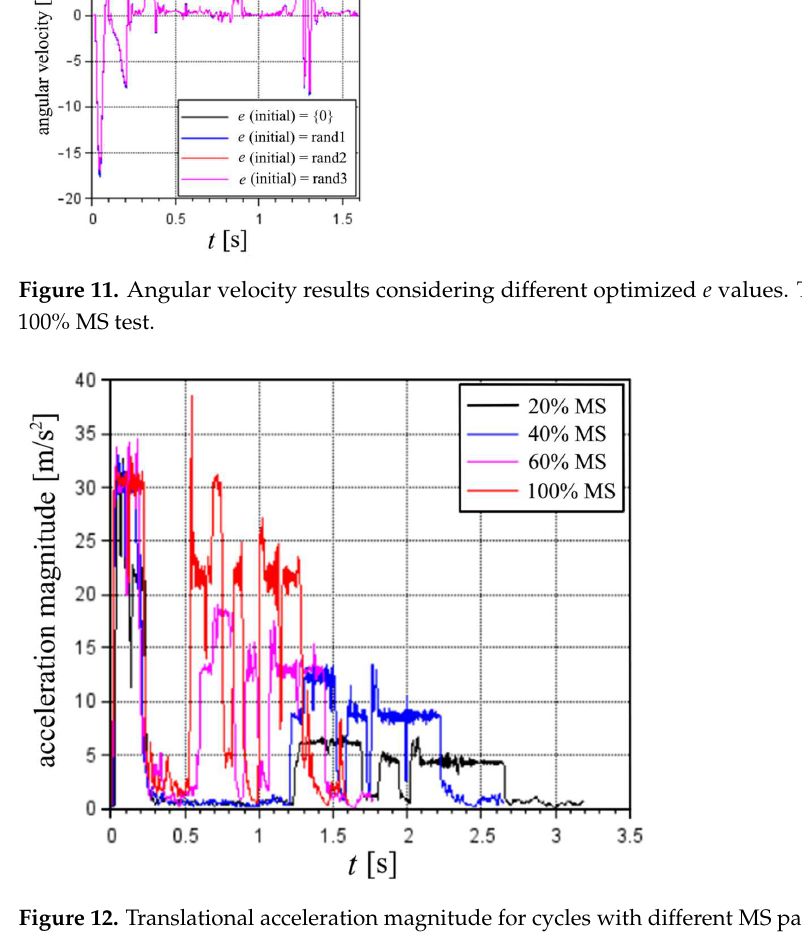
Figure 12. Translational acceleration magnitude for cycles with different MS parameters.